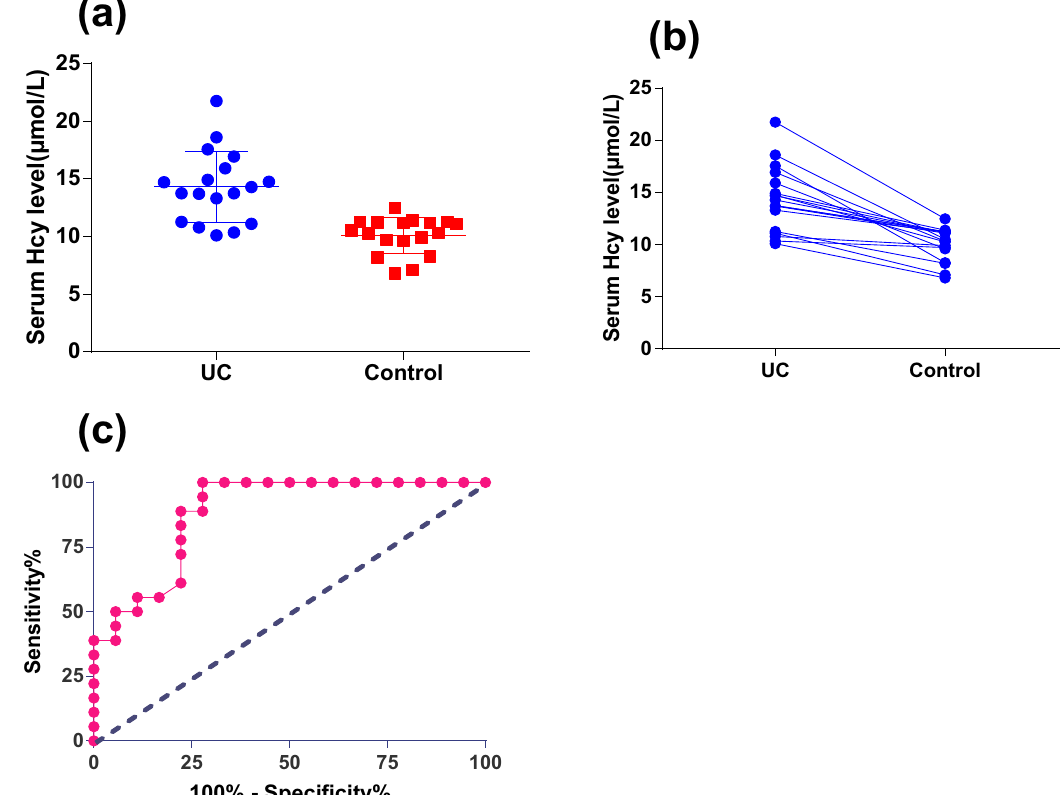
Figure 3: Serum Hcy level in UC and controls and its diagnostic performance. ( a ) Serum Hcy level in UC and controls. ( b ) Serum Hcy level in UC was signi fi cantly higher than that of corresponding controls. ( c ) ROC curve of serum Hcy as diagnostic biomarker for